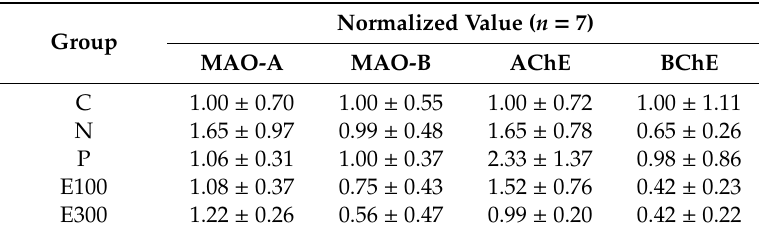
Normalized Value ( n = 7) Group MAO-A MAO-B